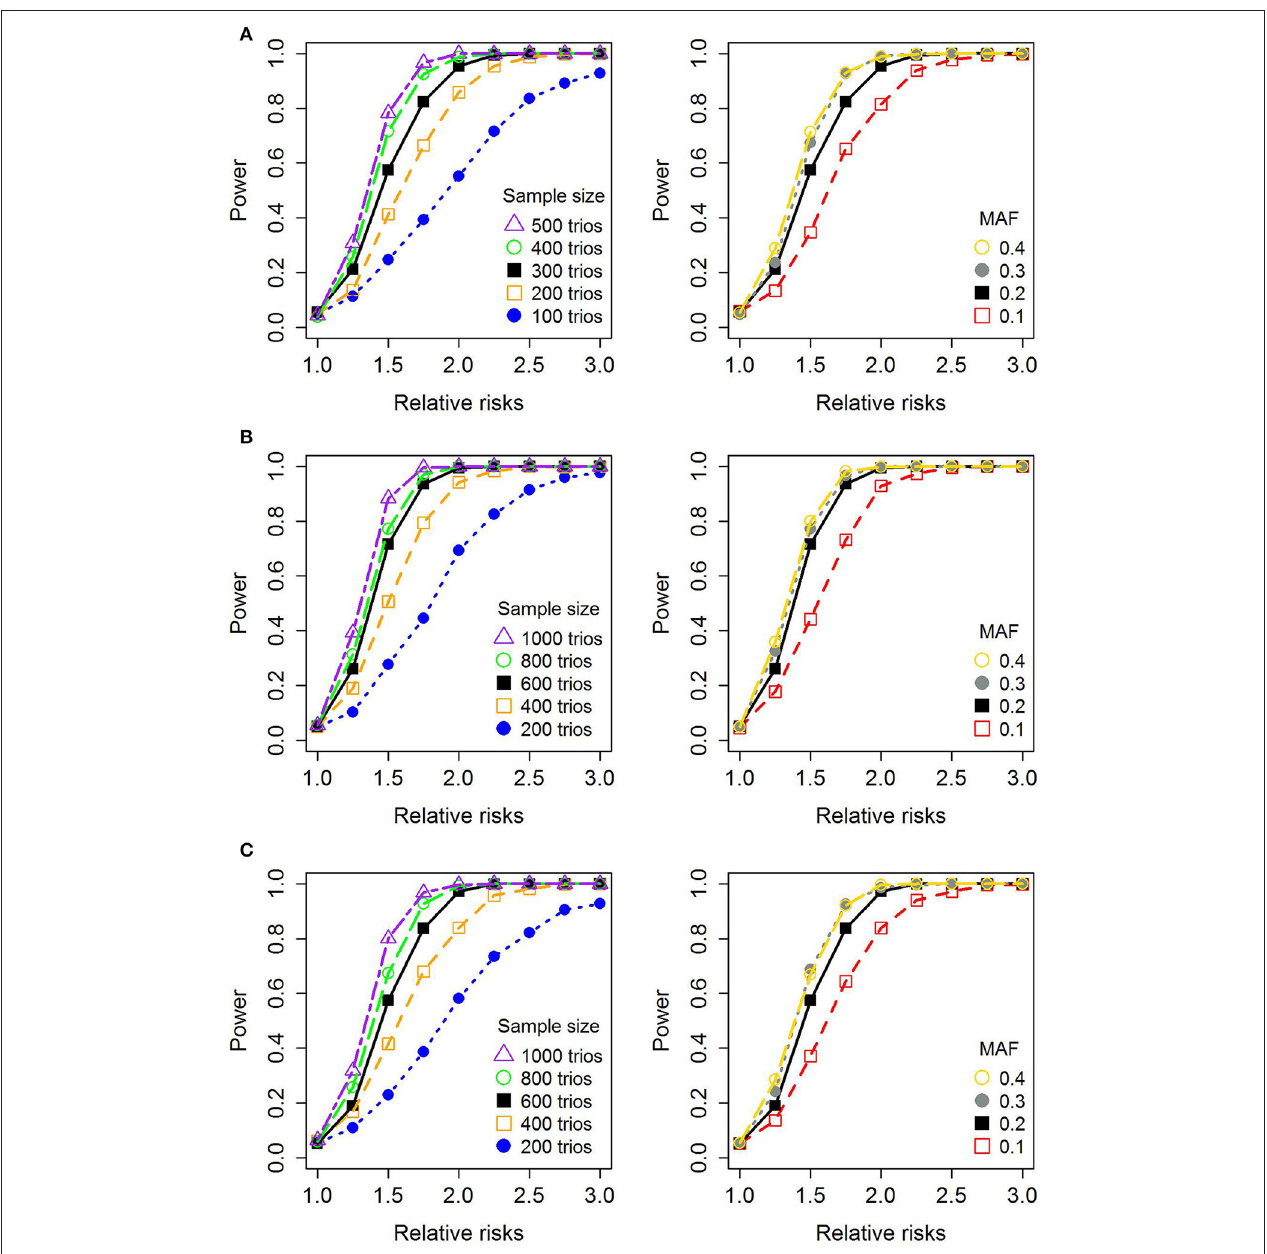
FIGURE 4 | Statistical power for a single SNP. (A) Shows the simulated power for the model restricted to girls only, (B) shows the simulated power for the model without X-inactivation, and (C) shows the simulated power for the model with X-inactivation. The figures on the left depict the power with increasing relative risk ratios (RRRs) (increasing values of RR m ; RR f = 1) and differing sample sizes of case-parent triads, using a fixed minor allele frequency (MAF) of 0.2. The figures on the right-hand side show the power with varying RRRs and MAFs, assuming a total of 300 case-parent triads for the girls-only analyses in (A) and 600 case-parent triads in (B,C) (assuming an equal distribution of boys and girls). We used a nominal significance level of 0.05 throughout. ( ITIH6 at Xp11.22), while the SNPs in haplotype (ii) are